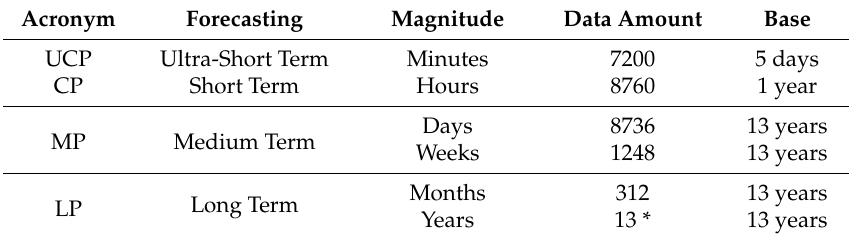
Table 1. Pattern of forecast